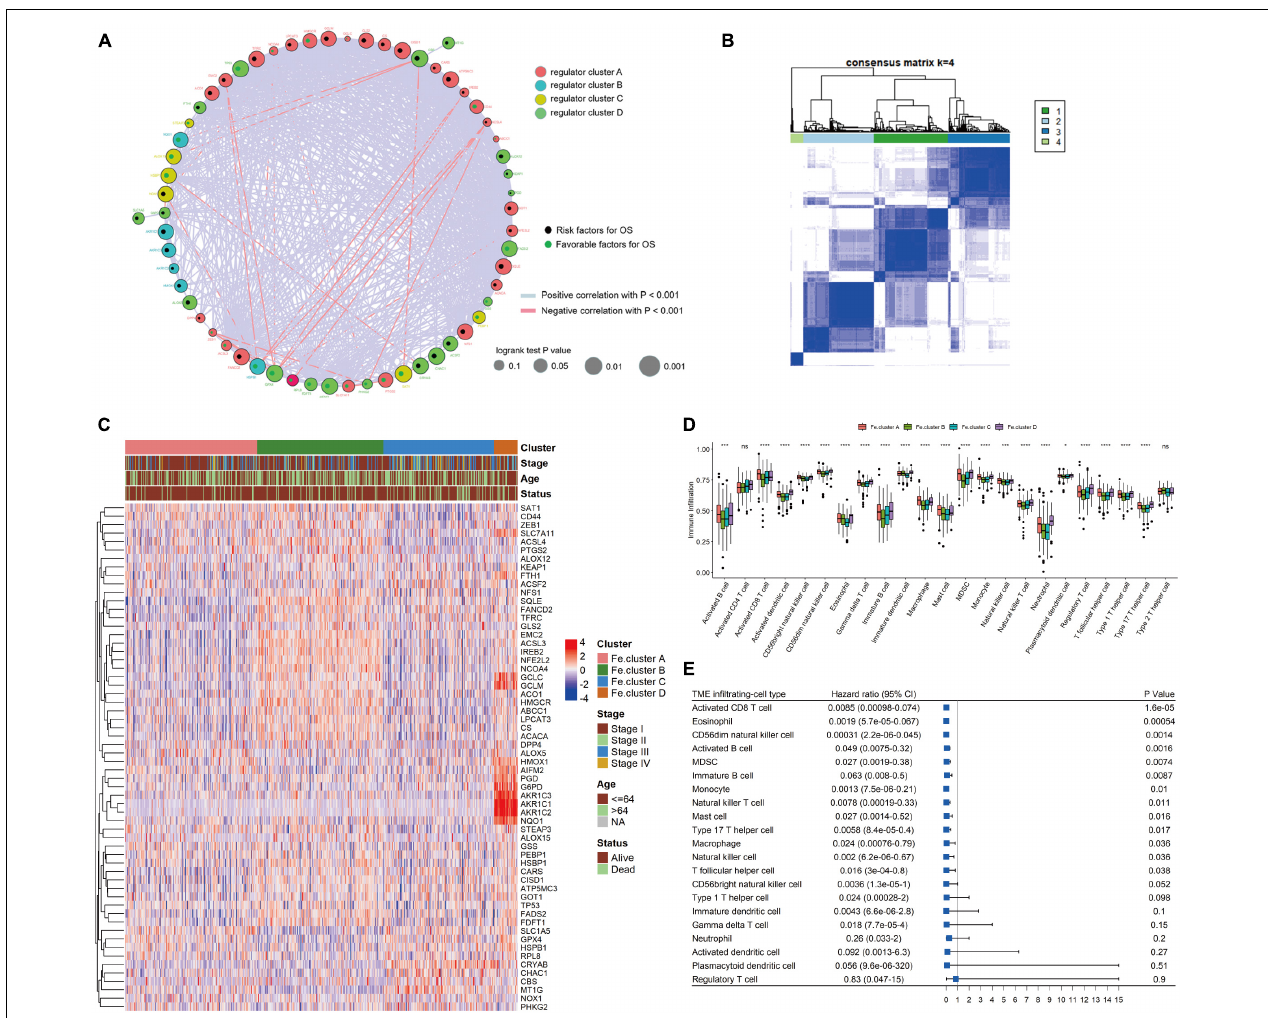
FIGURE 2 | Cluster analysis of ferroptosis genes in endometrial cancer (EC) samples. (A) Ferroptosis gene interaction network diagram. Nodes of different colors represent genes of different categories; the node size corresponds to the log-rank test p -value of Cox risk regression analysis. The more significant the prognostic effect is, the larger the node. The green dots indicate good prognostic factors, and the black dots indicate prognostic risk factors. (B) Consensus clustering of the expression values of 60 ferroptosis genes in 544 EC samples. (C) Expression heat map of ferroptosis genes in Fe.clusters. (D) Box plot showing the difference in the proportion of 23 infiltrating cells in different Fe.clusters. (E) The prognostic forest plot of differentially infiltrated cells. Each row represents a type of infiltrated cell. The third column graphically displays the distribution of hazard ratios (HRs) in the 95% confidence interval. The value of the abscissa represents the HR. Ns, p > 0.05; * p < 0.05; ** p < 0.01, *** p < 0.001; **** p <